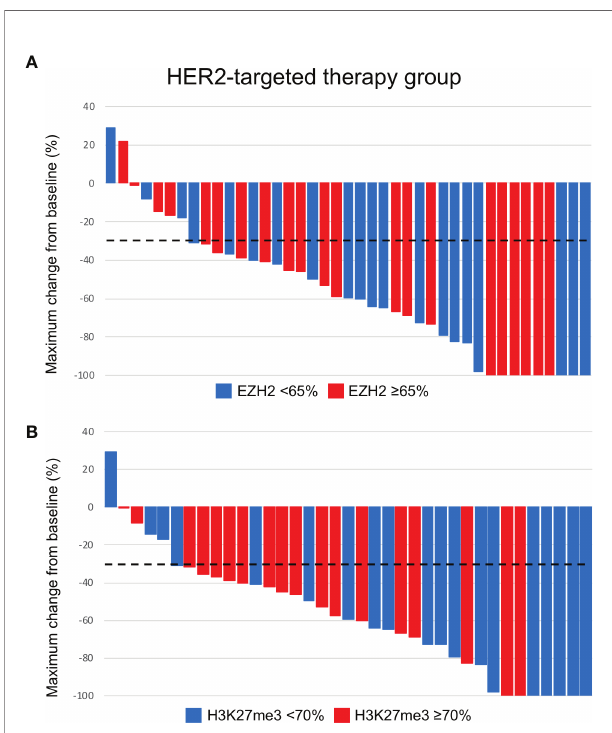
FIGURE 7 | Waterfall plots of maximum changes from baseline according to the EZH2 (A) and H3K27me3 (B) status in patients who received HER2-targeted therapy. The dotted line indicates -30% of maximum change from